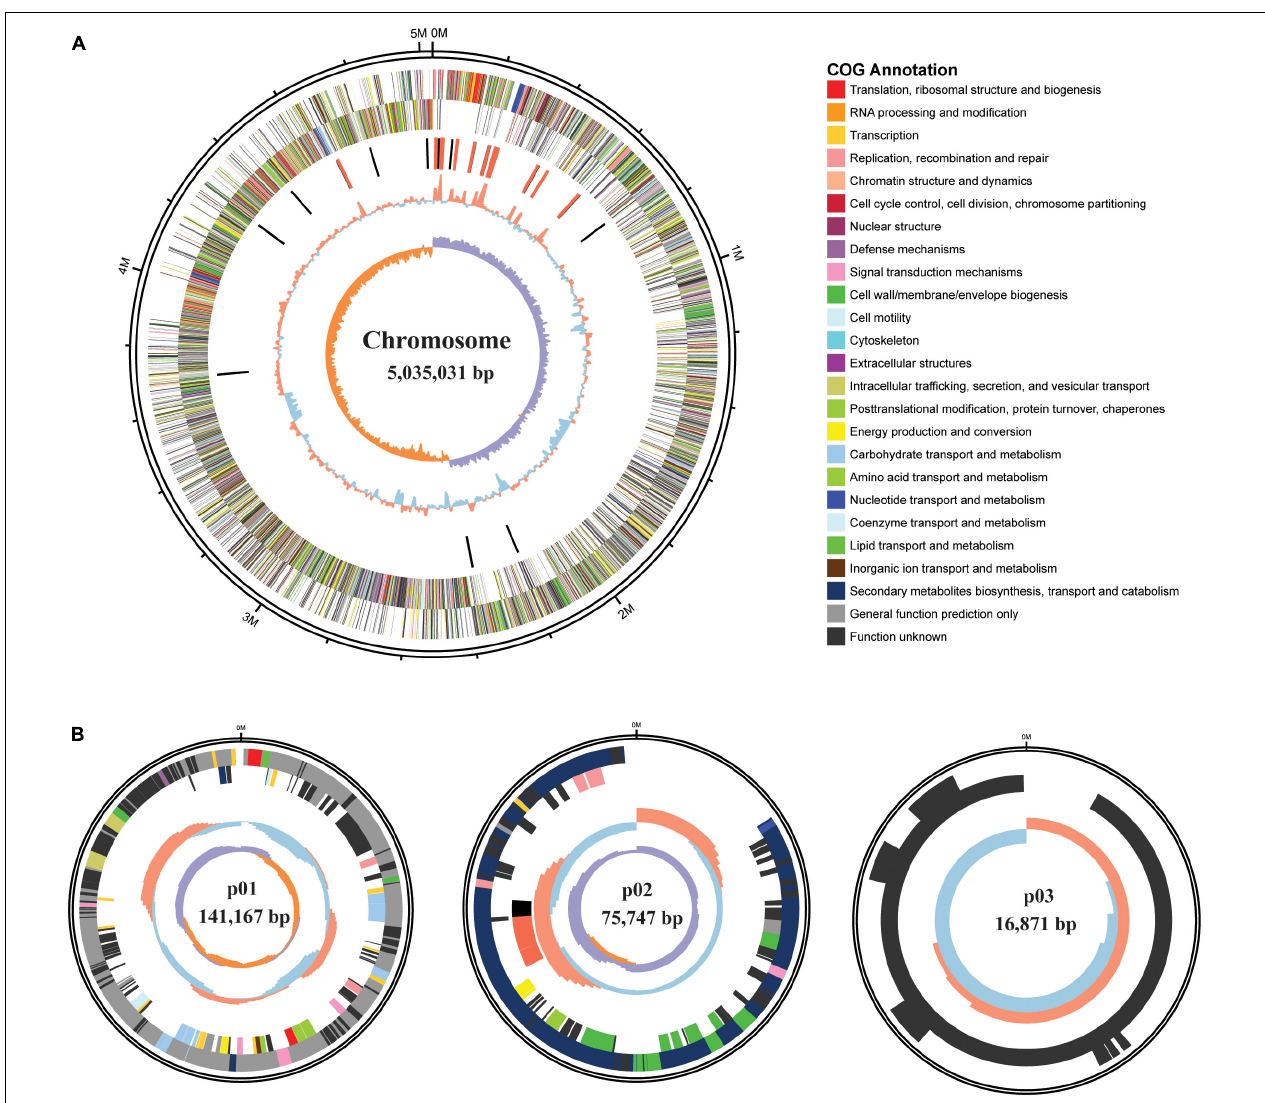
FIGURE 3 | Genome maps of B. megaterium HGS7. (A) Circular chromosome. (B) Plasmids. From outside of the map to inside: size of the genome; predicted protein-coding genes on the positive strand (circle 2) and negative strand (circle 3) with different colors representing different COG functional classifications; rRNA (red) and tRNA (black); GC content, with > 38.27% GC (red) and ≤ 38.27% GC (blue); GC skew, with G% > C% in purple and G% < C% in